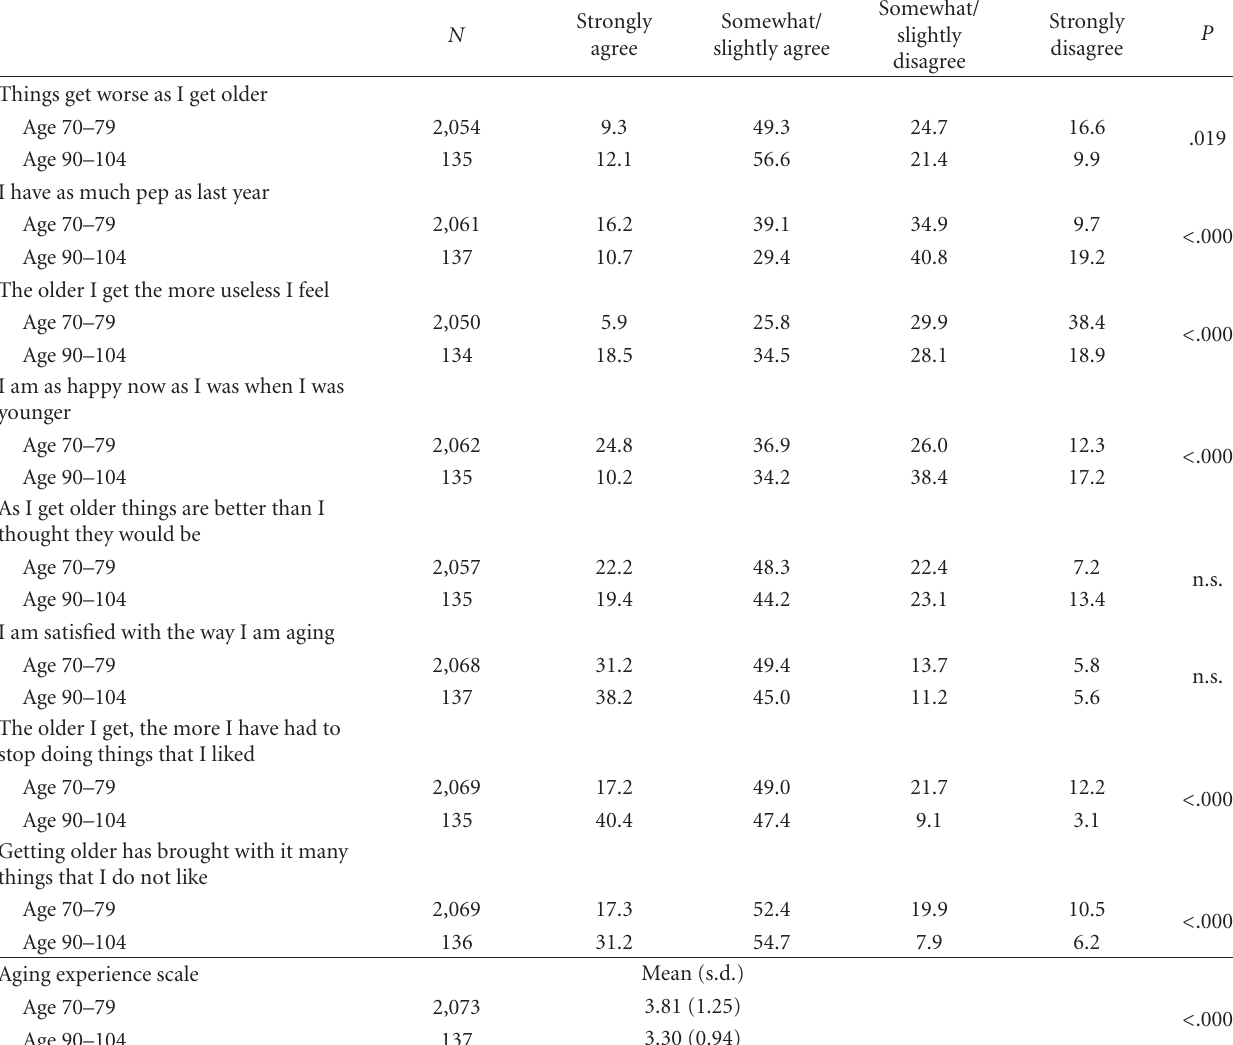
Table 5: Di ff erences in perceptions of the aging experience between the young old (age 70–79) and the very old (age 90–104), HRS 2008.